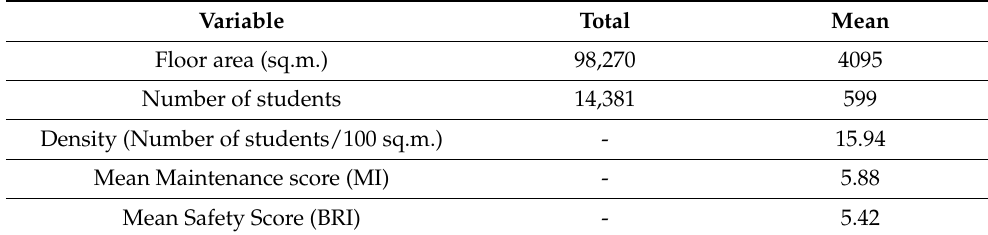
Table 4. Parameters of educational institutes’